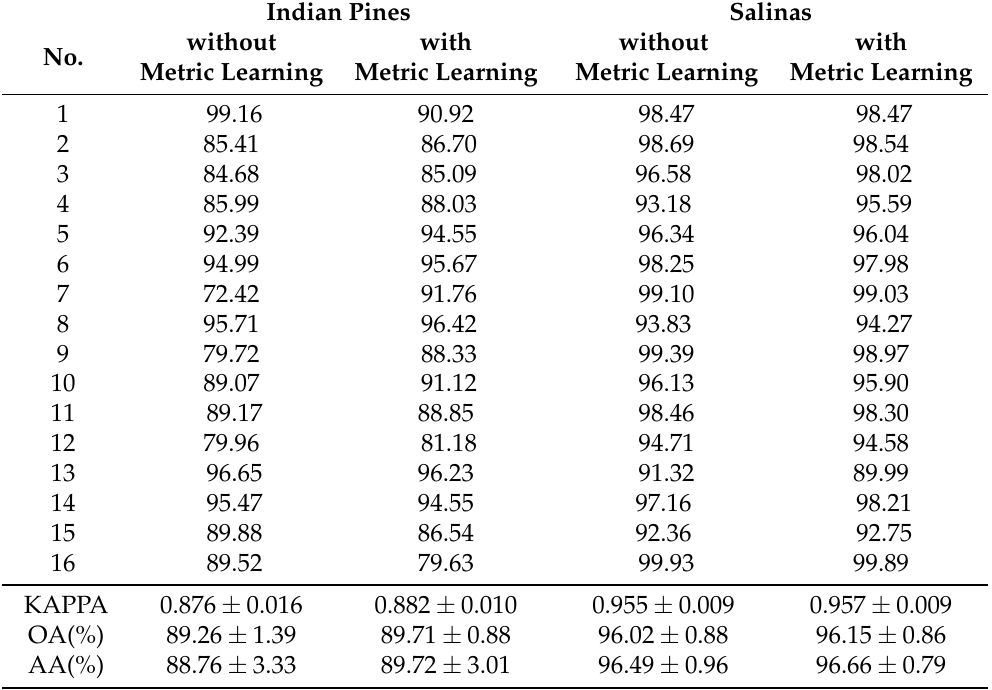
Table 16. Classification results of the transformer without metric learning and the transformer with metric